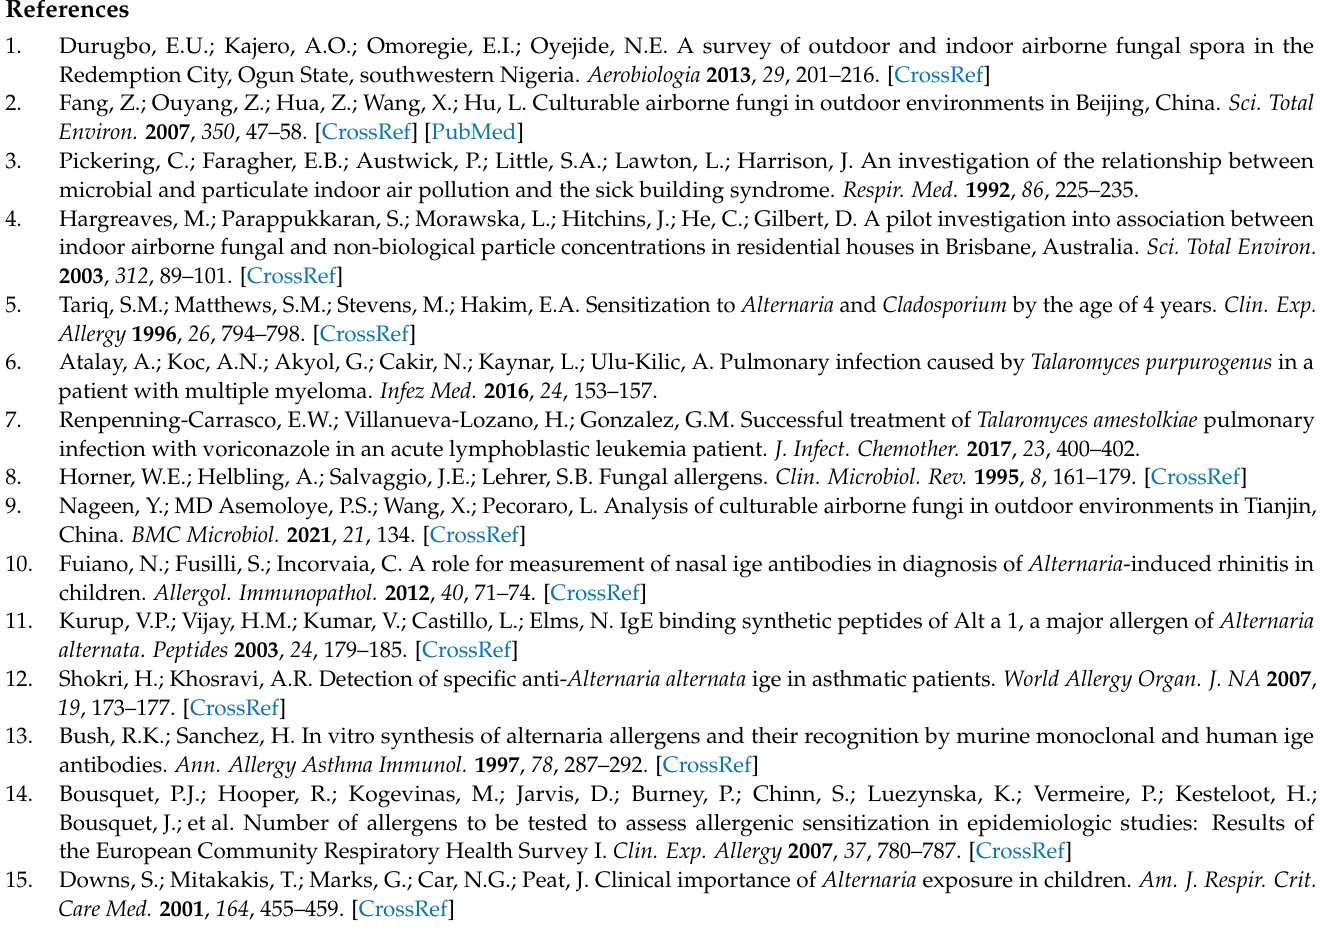
Table S4: Correlation analysis between fungal abundance and environmental parameters. Table S5: Relative abundances of top ten genera in five sampling